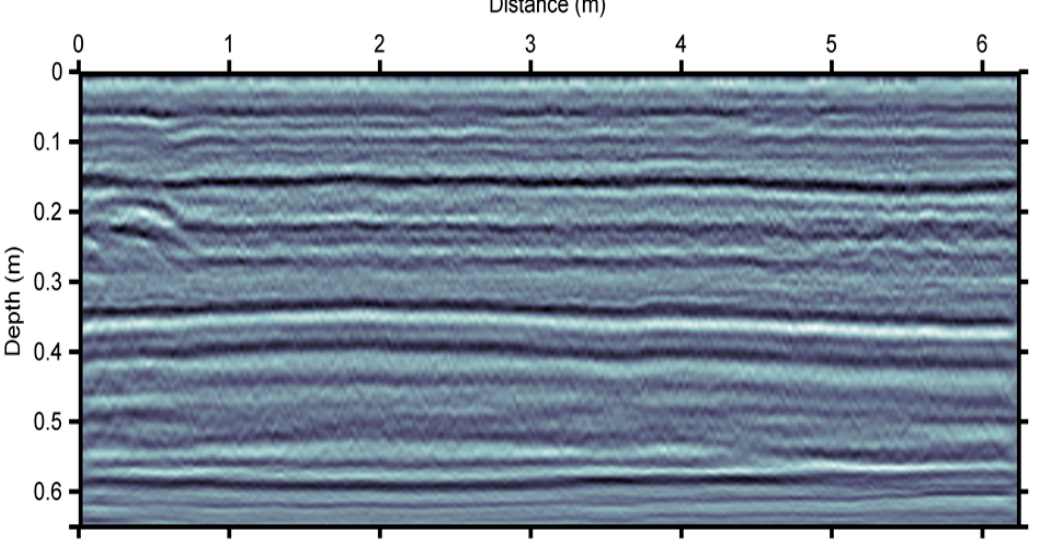
Figure 11. The GPR section subject to migration and time-to-depth conversion after deconvolution. The ground-truth information at the base of the time-to-depth conversion is reported in Table 4.